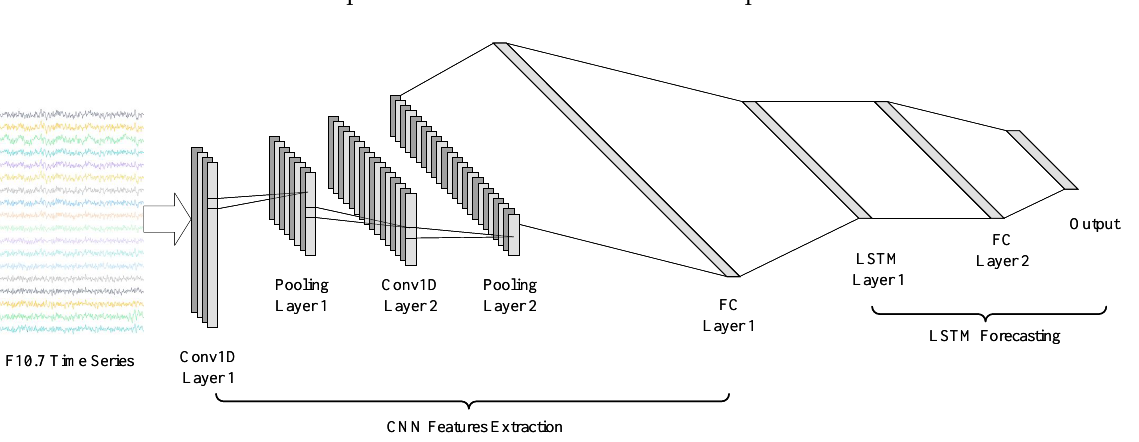
Figure 2. Structure diagram of